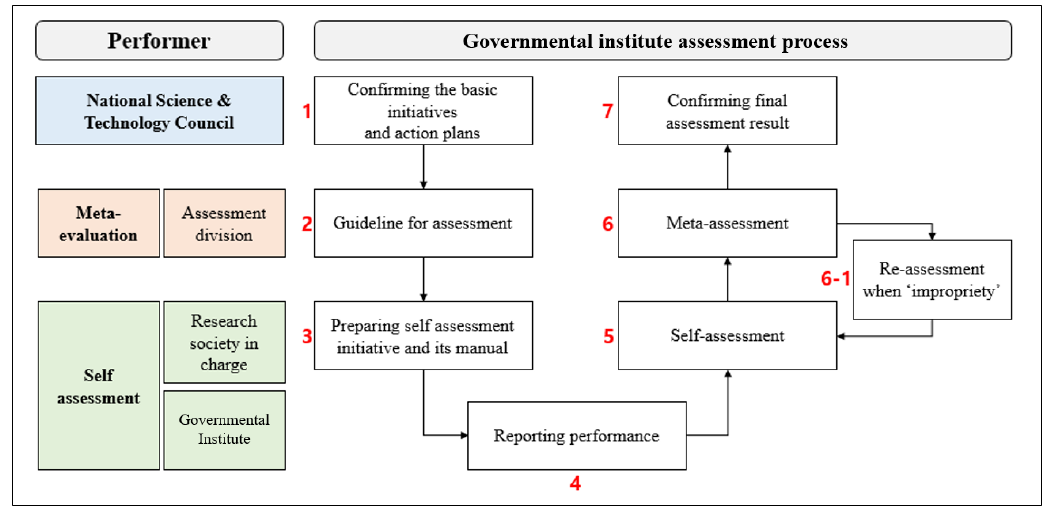
Figure 1. Flow chart of the feedback system for governmental institutes in Korea.